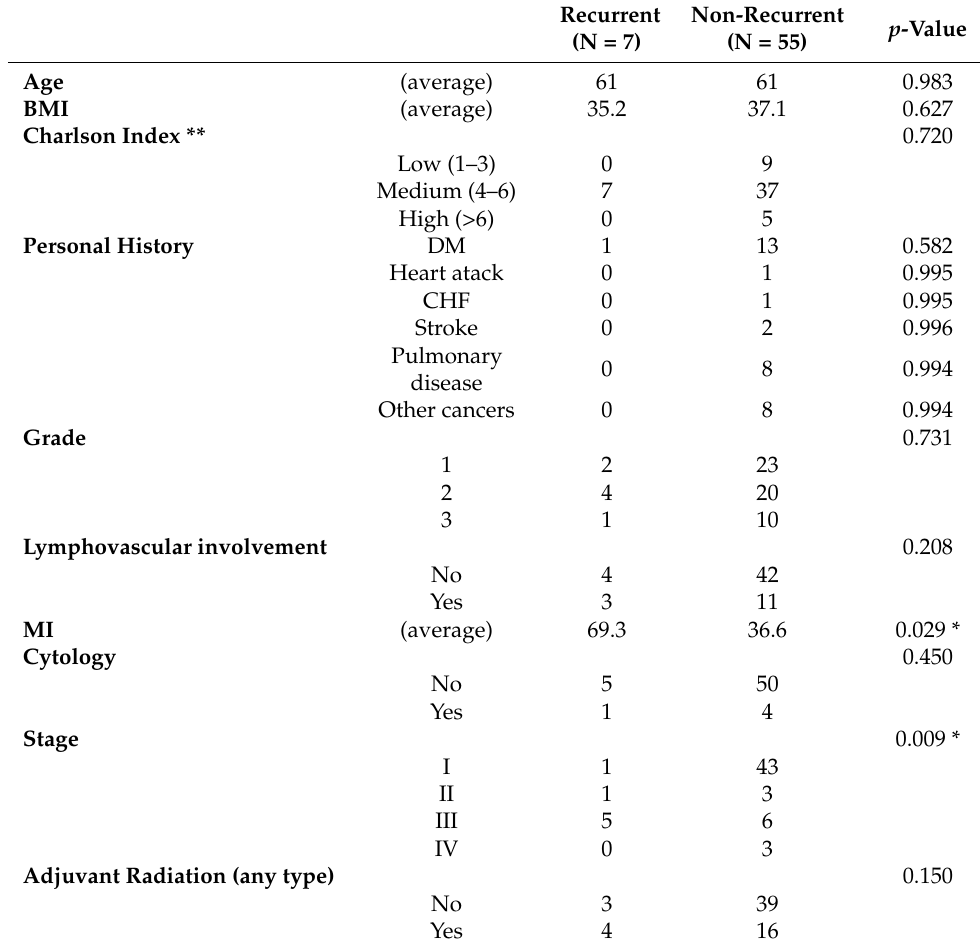
Table 1. Clinical patient characteristics. These are the baseline variables determined at treatment completion and included in the